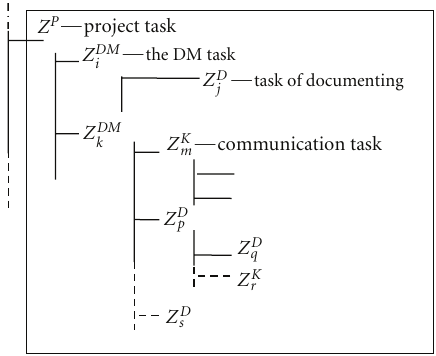
Figure 14: Fragment of the task tree reflecting the relations between tasks for decision making.